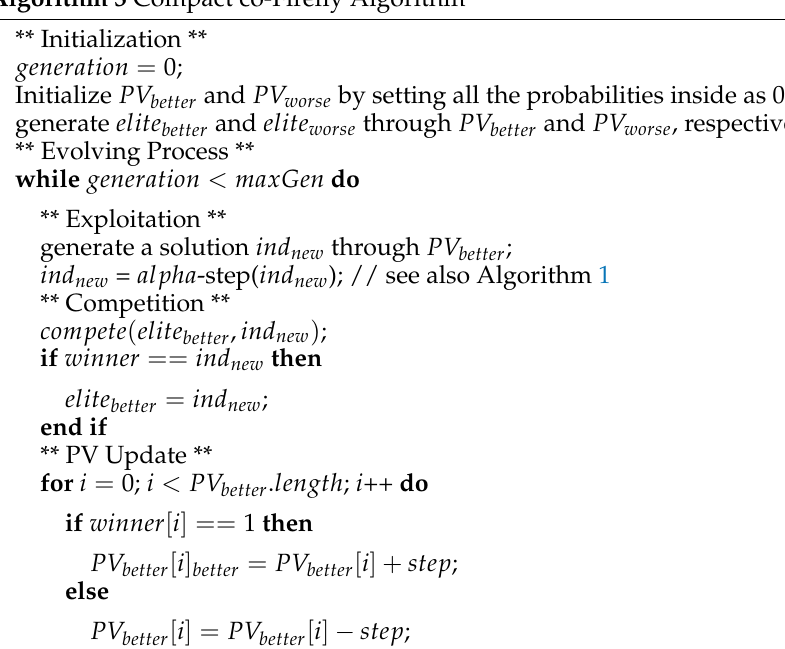
Algorithm 3 Compact co-Firefly